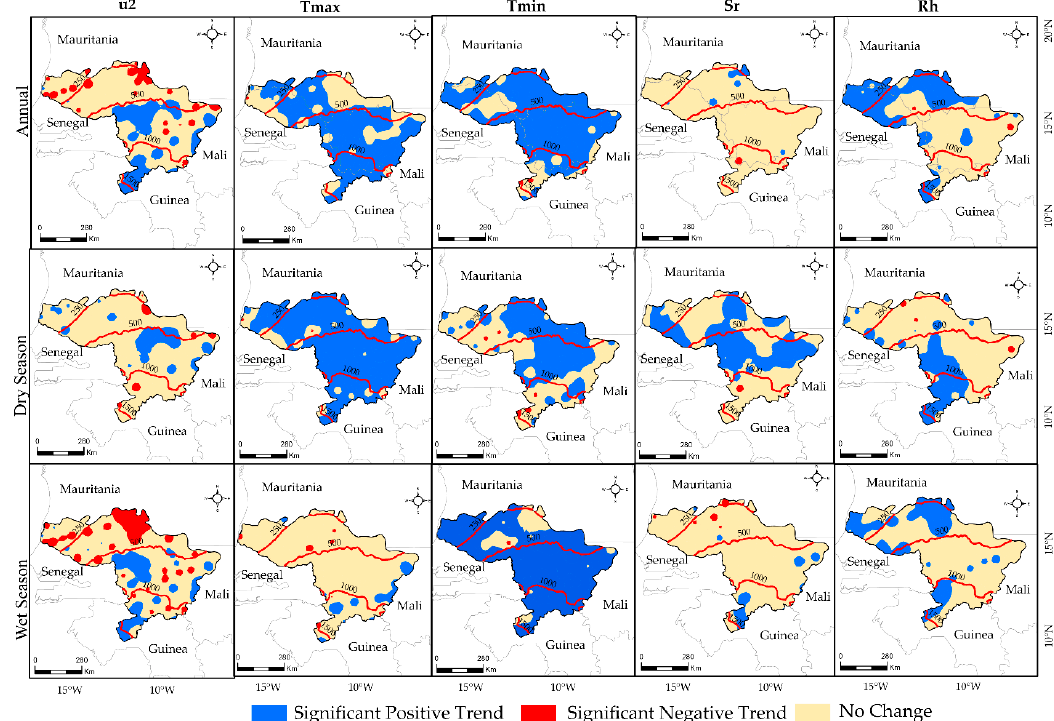
Figure 7. Spatial distribution of Mann-Kendall’s Z of different climatic variables: u2 wind speed, Tmax maximum temperature, Tmin minimum temperature, Sr Solar radiation, Rh relative humidity.